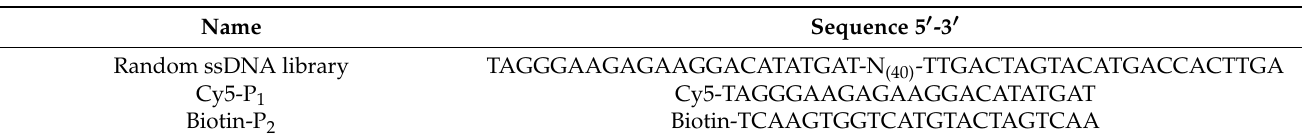
Table 1. DNA sequences of the random DNA library with 40-base random sequence, forward and reverse primer sequences in 5 ′‐ 3 ′ orientation.